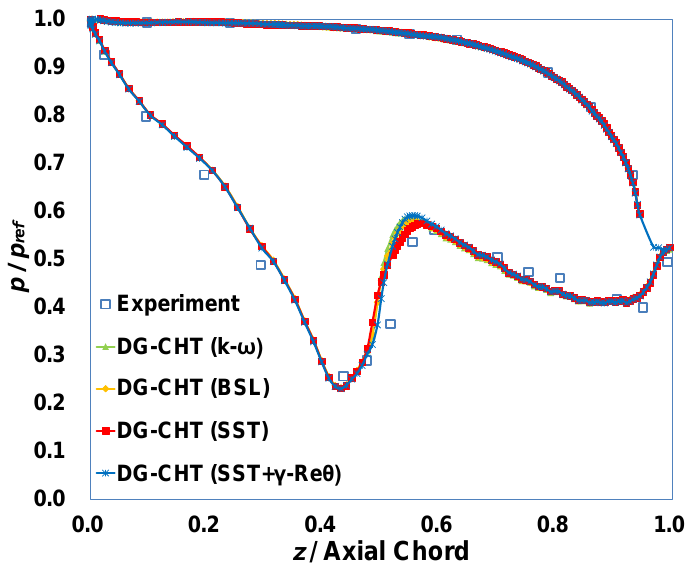
Figure 9. Pressure distributions on the vane surface.